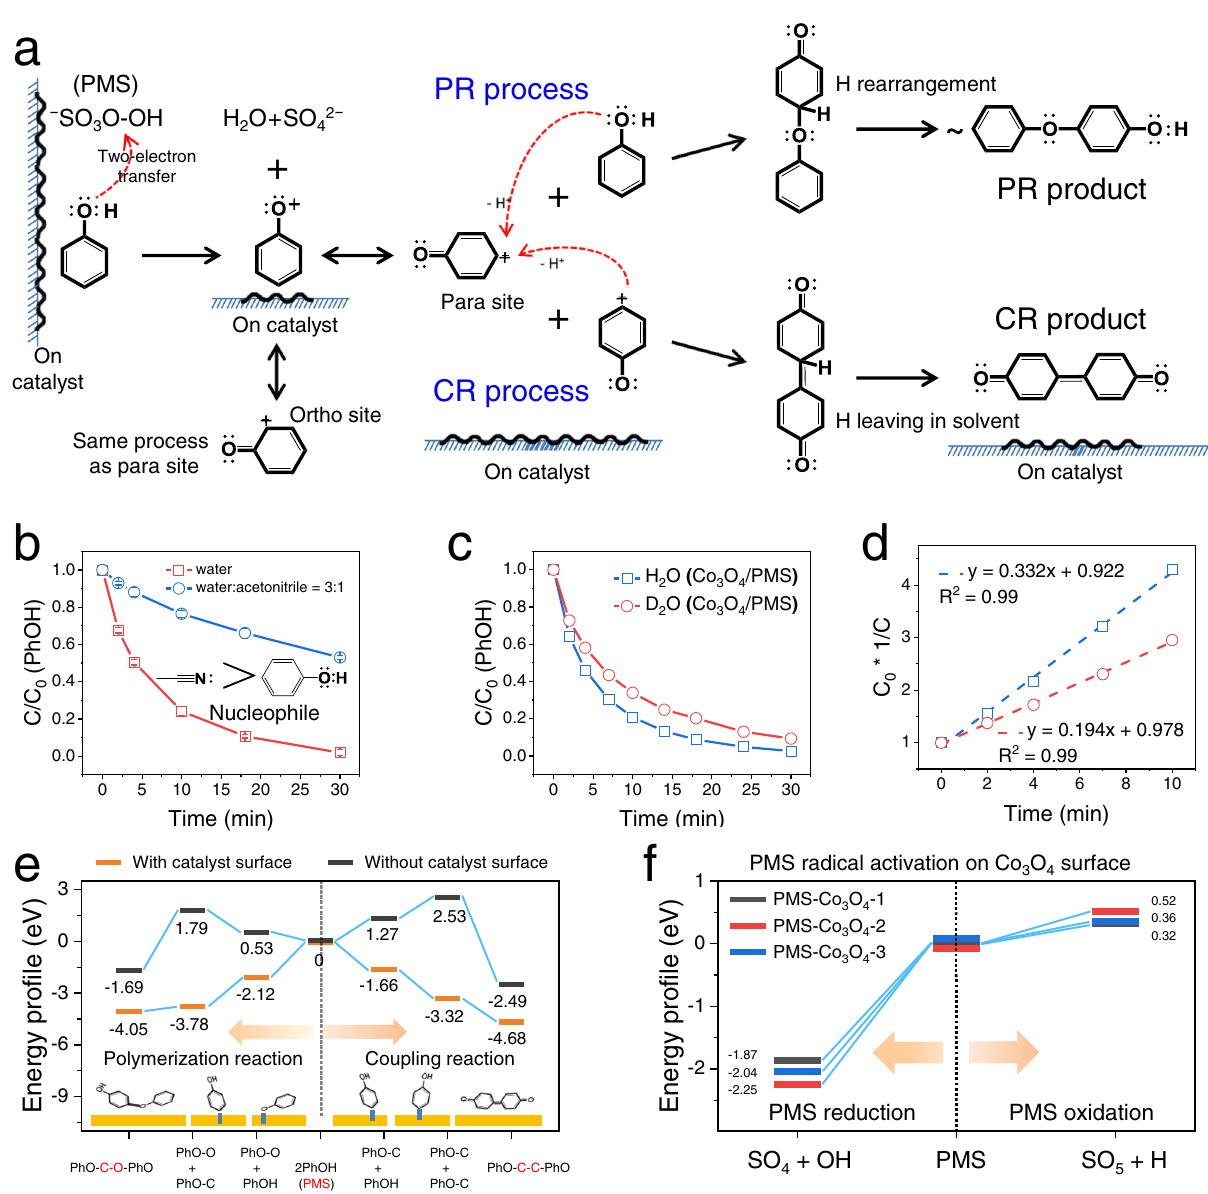
Fig. 5 Evolution process of DOTP and thermodynamic feasibility analysis. a Proposed elementary reaction pathways of the oxidative coupling and polymerization of PhOH on the catalyst surface in the DOTP. b Competitive inhibition of acetonitrile on PhOH removal. c Removal processes of PhOH in H 2 O and D 2 O. d Corresponding kinetic curves of c . The KIE value was calculated to be K H / K D ~1.4, which is in the range of secondary kinetic isotope effects. e Thermodynamic potential energy curves during the reaction in DOTP. f Thermodynamic potential energy curves of the reductive and oxidative activation processes of PMS on the Co 3 O 4 surface in the AOP. PR polymerization reaction, CR coupling